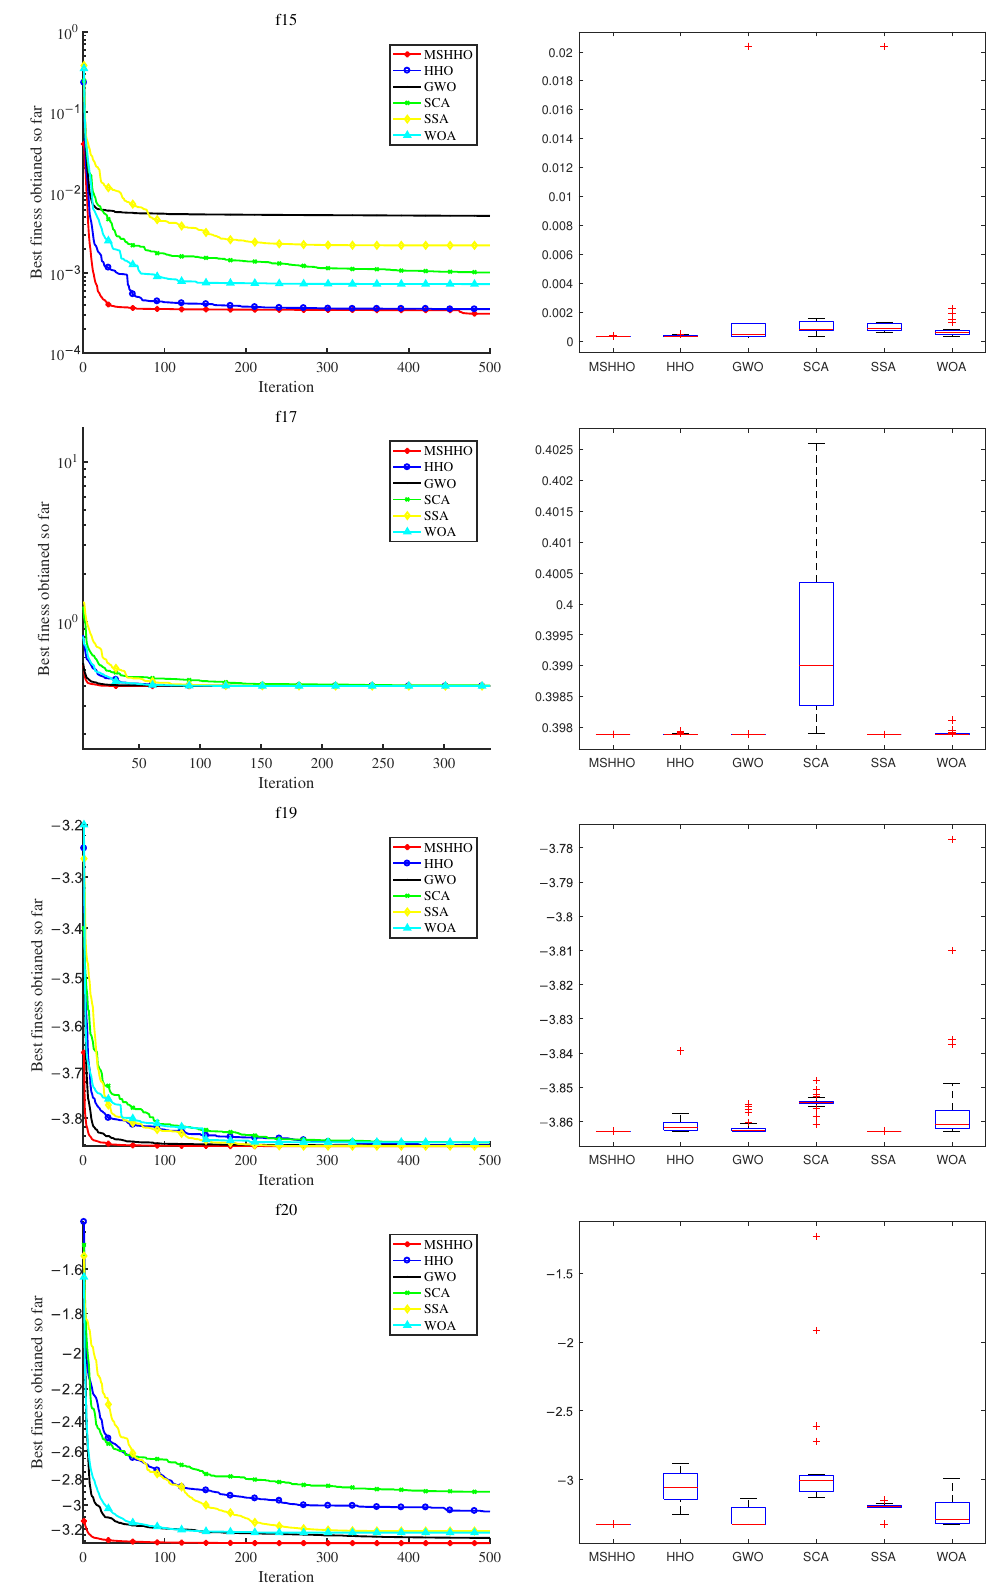
Figure 8. Qualitative results of F15, F17, F19, and F20